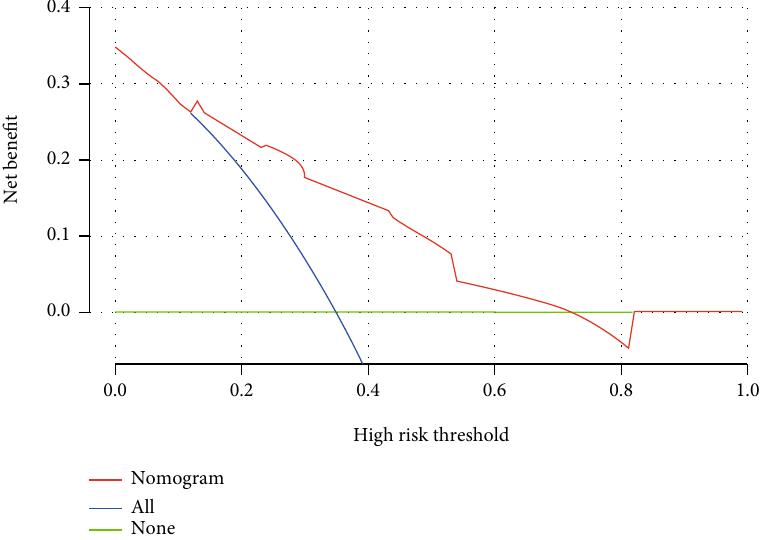
Figure 4: Decision curve analysis of the nomogram for predicting